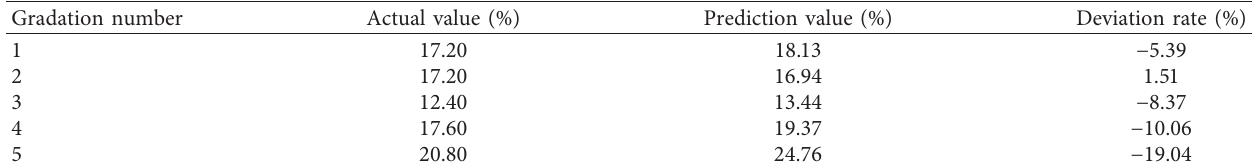
Table 10: Predictive valuation